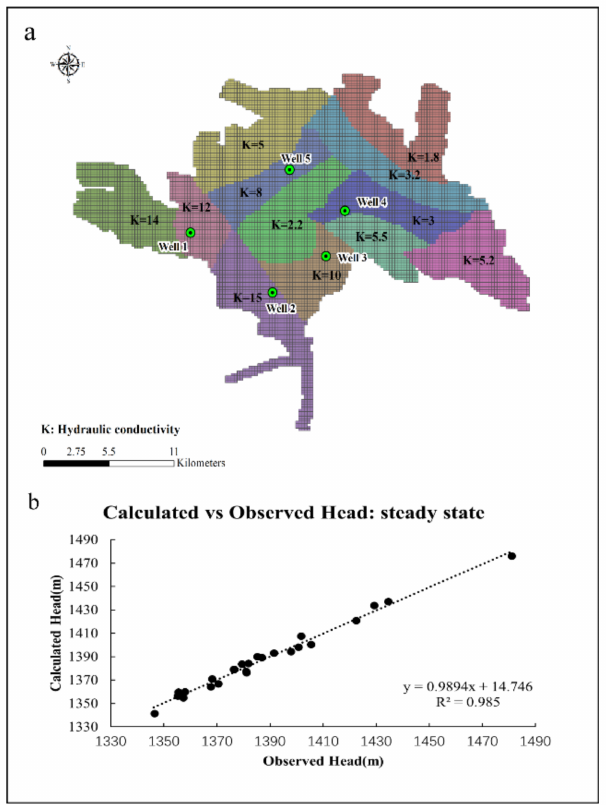
Figure 6. Comparison of the observation well and the water level in the model under steady-state conditions. ( a ): Spatial distribution of hydraulic conductivity in shallow aquifers. ( b ): Water level comparison between observation well and model under steady state